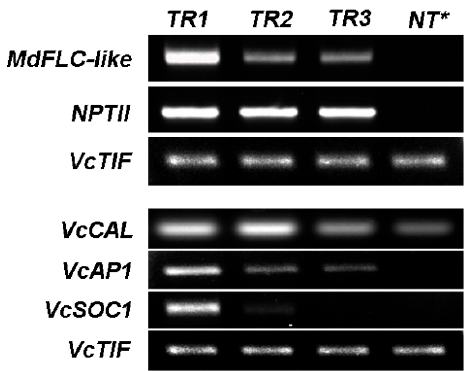
Figure 6. Expression analysis of 35S -MdFLC and several selected flowering pathway genes in the fully-expanded leaf tissues of transgenic blueberry plants. TR1, TR2, and TR3: three independent transgenic events. NT: nontransgenic plants, *cDNA mixture of three NT plants. VcTIF was used for normalization of the transcript levels. All samples were technically repeated at least three times.